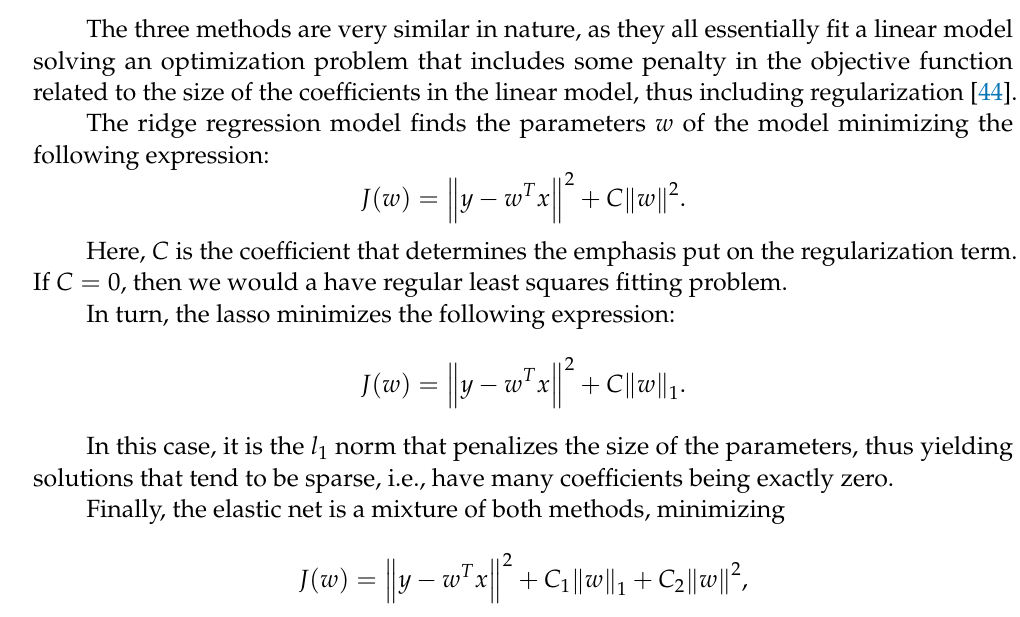
Figure 3. Distribution of fruity aroma and defect intensity for the studied